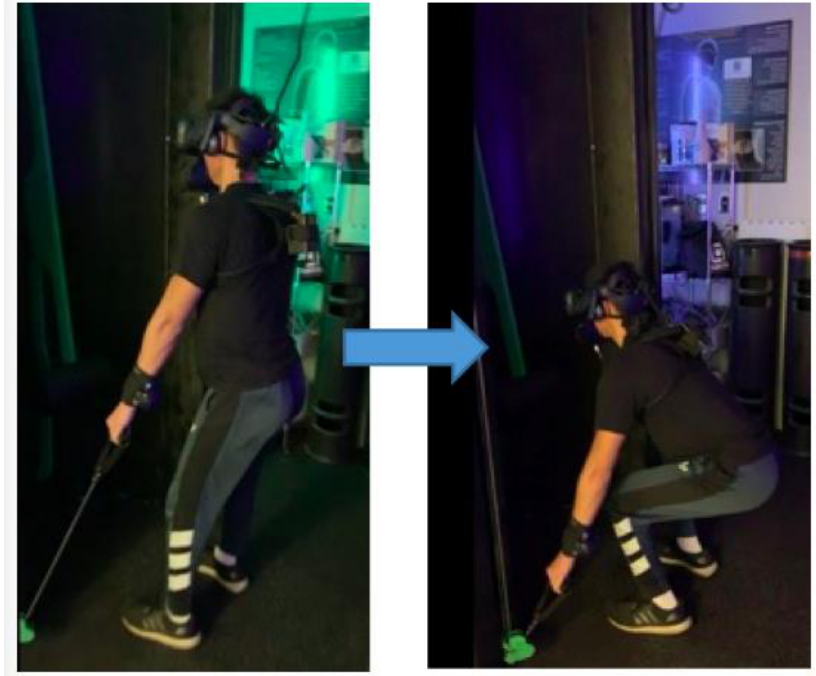
Figure 3. Participant donning an IVR head-mounted-display while performing a cable-based front squat using the Blackbox VR ® system.